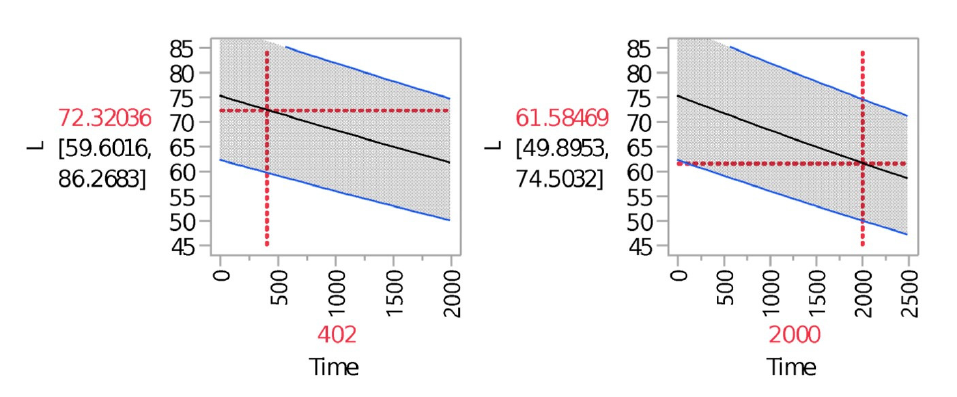
Figure 7. Degradation predictions: